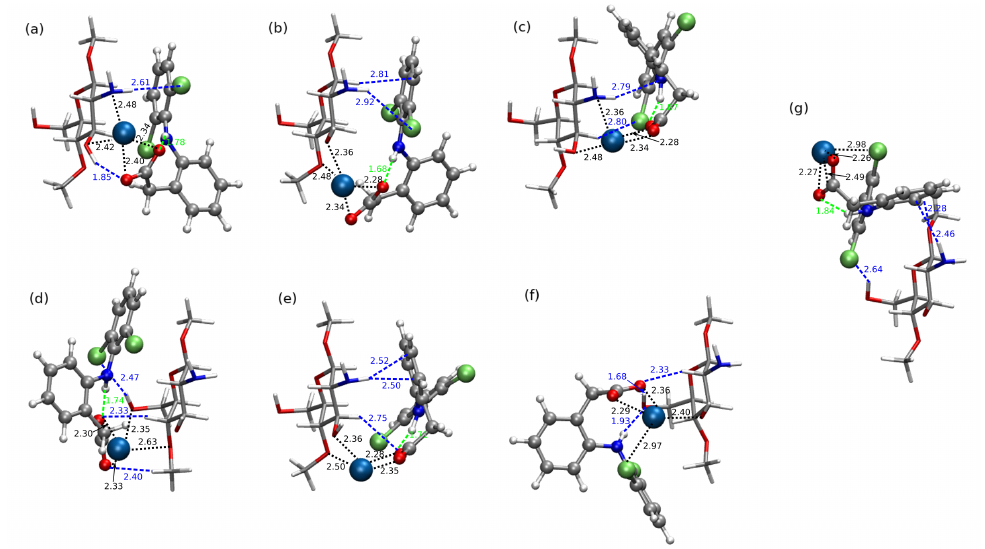
Figure 1. B97-D3/6-311++G(d,p) optimized structures of chitozan unit interacting with DFNa (explicit given the distances between the sodium cation and four coordinated atoms in Å—black color, and hydrogen–hydrogen-bond-acceptor distances—intramolecular in green and intermolecular in blue). The strongest attraction: ( a ) CS1:DFNa 4 , ( b ) CS1:DFNa 1 , ( c ) CS1:DFNa 6 , ( d ) CS1:DFNa 5 , ( e ) CS1:DFNa 9 , ( f ) CS1:DFNa 7a and weakest attraction ( g ) CS1:DFNa 10 . Sodium cation depicted as large skye blue ball, DFNa in Corey–Pauling–Koltun representation and CS1—in licorice with following atom colors: chlorine—lime green, oxygen—red, nitrogen—cobalt blue, carbon—silver, hydrogen—white.